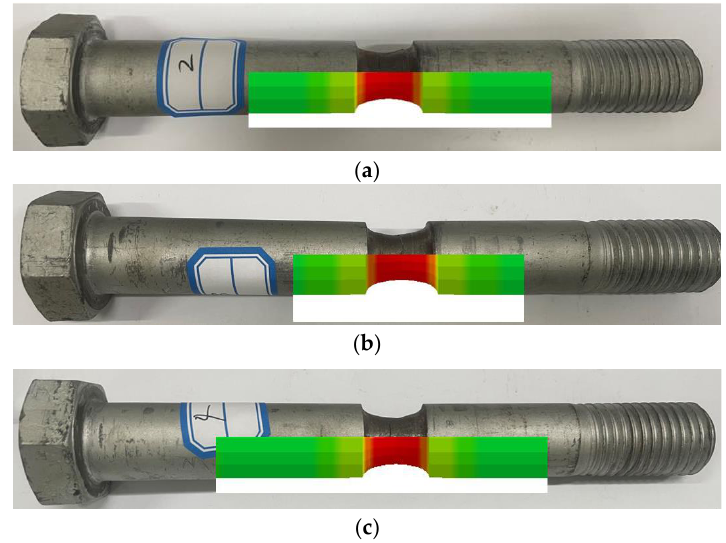
Figure 27. Comparison the VCSB fracture between simulation and experiments with preload: ( a ) Test 2 and FEM-180, ( b ) Test 3 and FEM-255, ( c ) Test 4 and FEM-343.